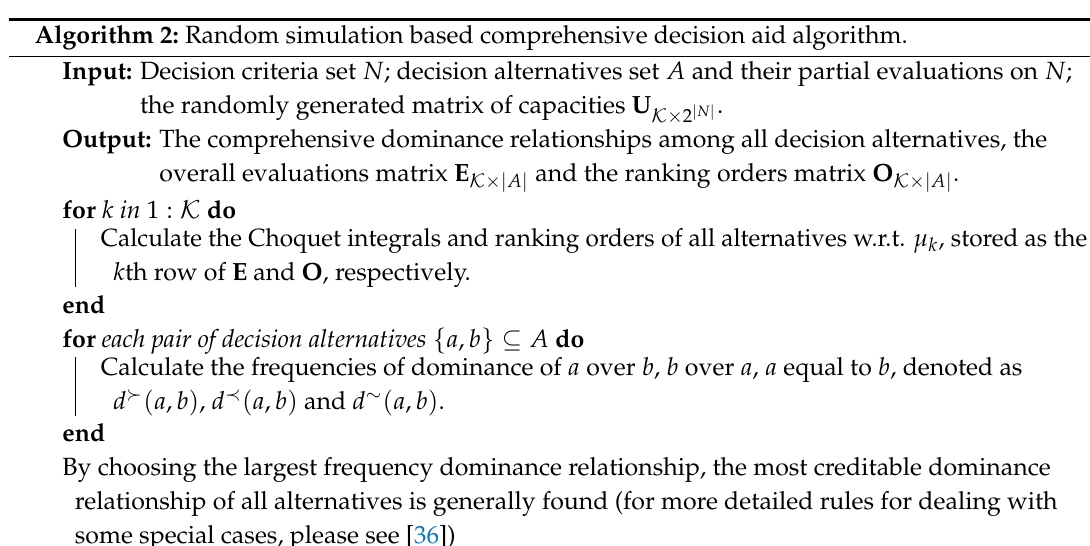
Algorithm 2: Random simulation based comprehensive decision aid